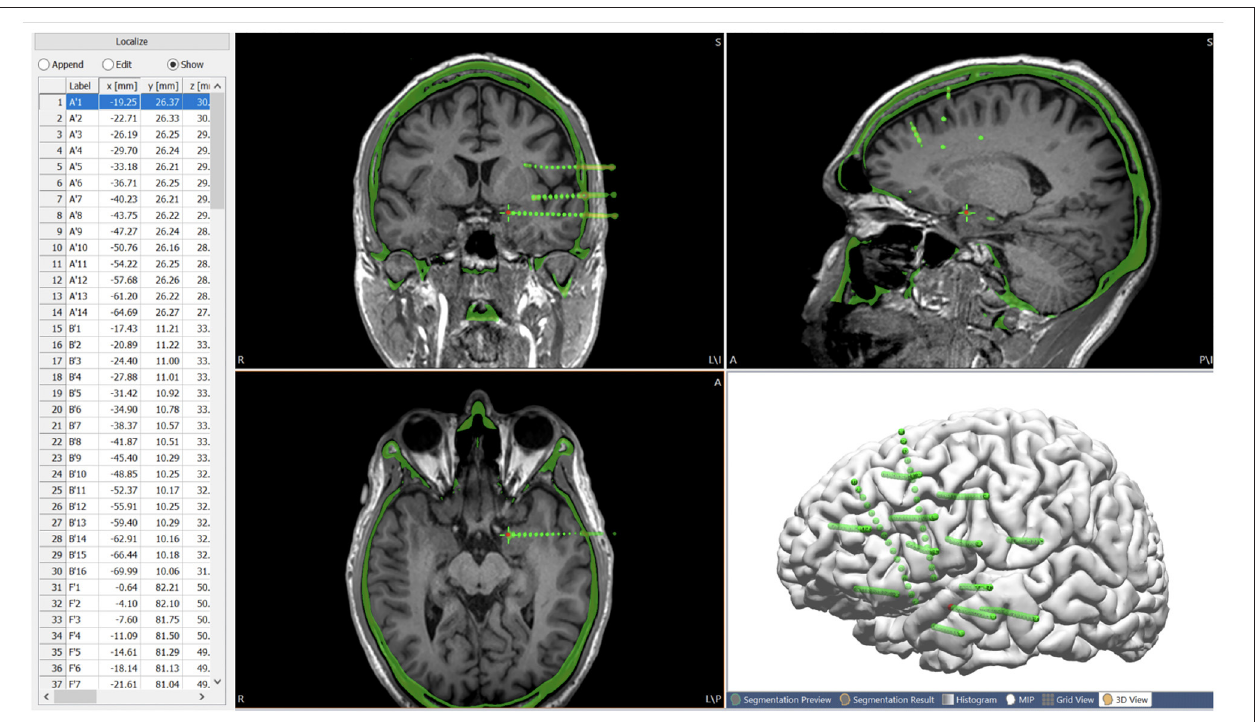
FIGURE 4 | Post-SEEG-implantation CT images co-registered with the T1-weighted base image, with all the electrode contacts segmented from the CT (center of highest intensity) and stored as a list of localize points with coordinates for the electrode contacts. Green spheres indicate extracted electrode contacts. Red contact indicates the current electrode contact (highlighted on the list of localize points), the location of which is synchronized on the MRI and CT.